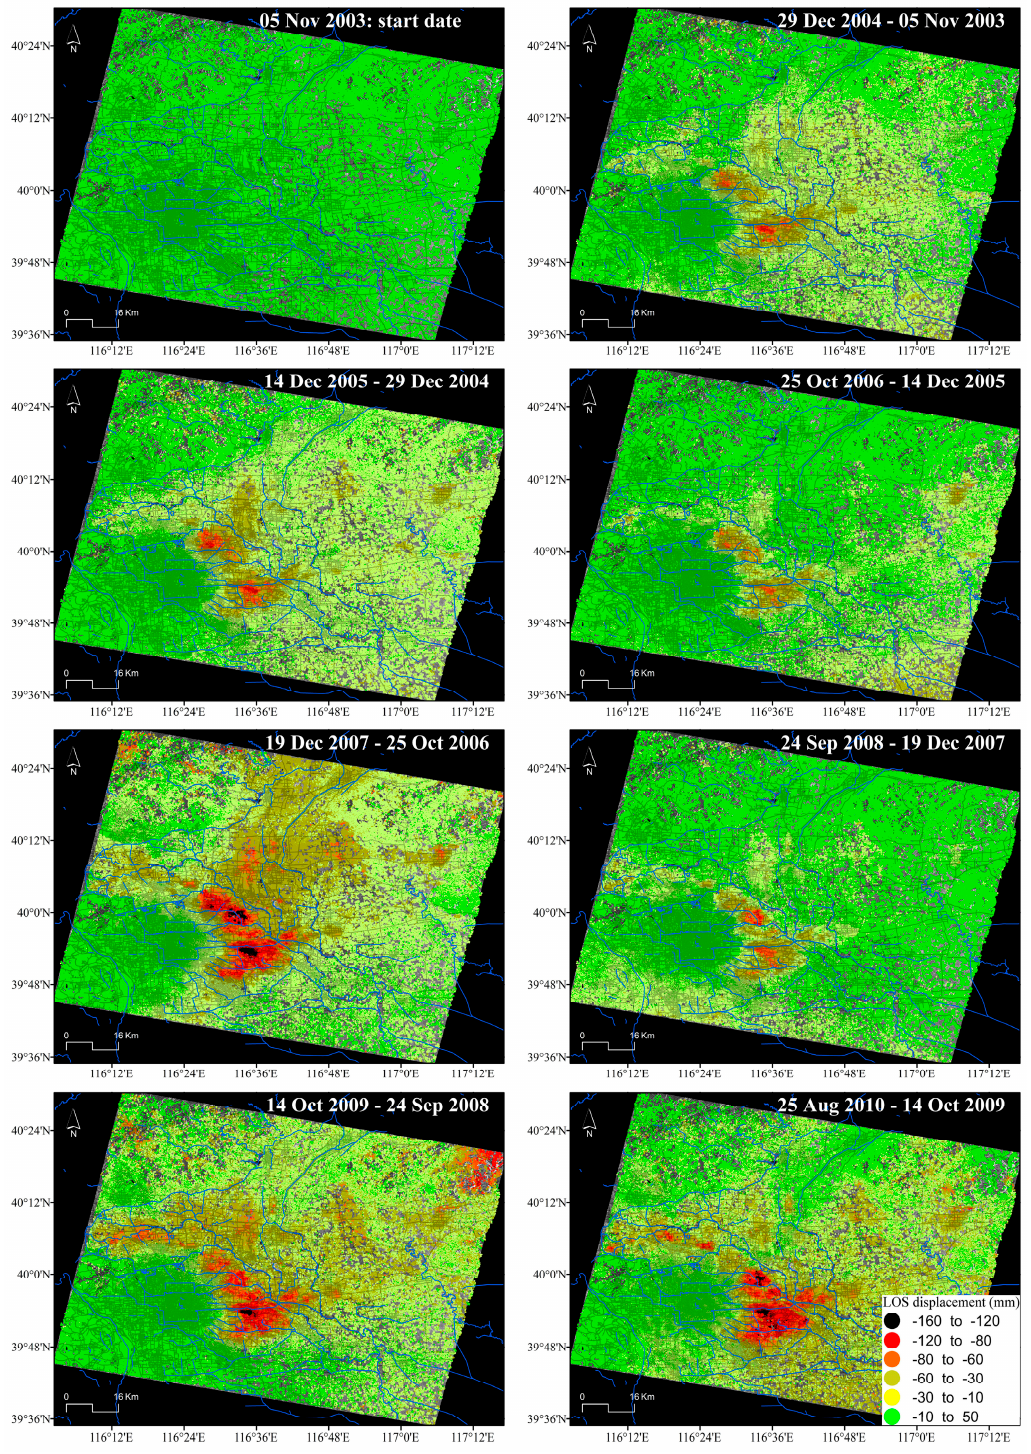
Figure 8. LOS displacements difference in Beijing obtained from Envisat ASAR images between the acquisition dates selected in Figure 4.